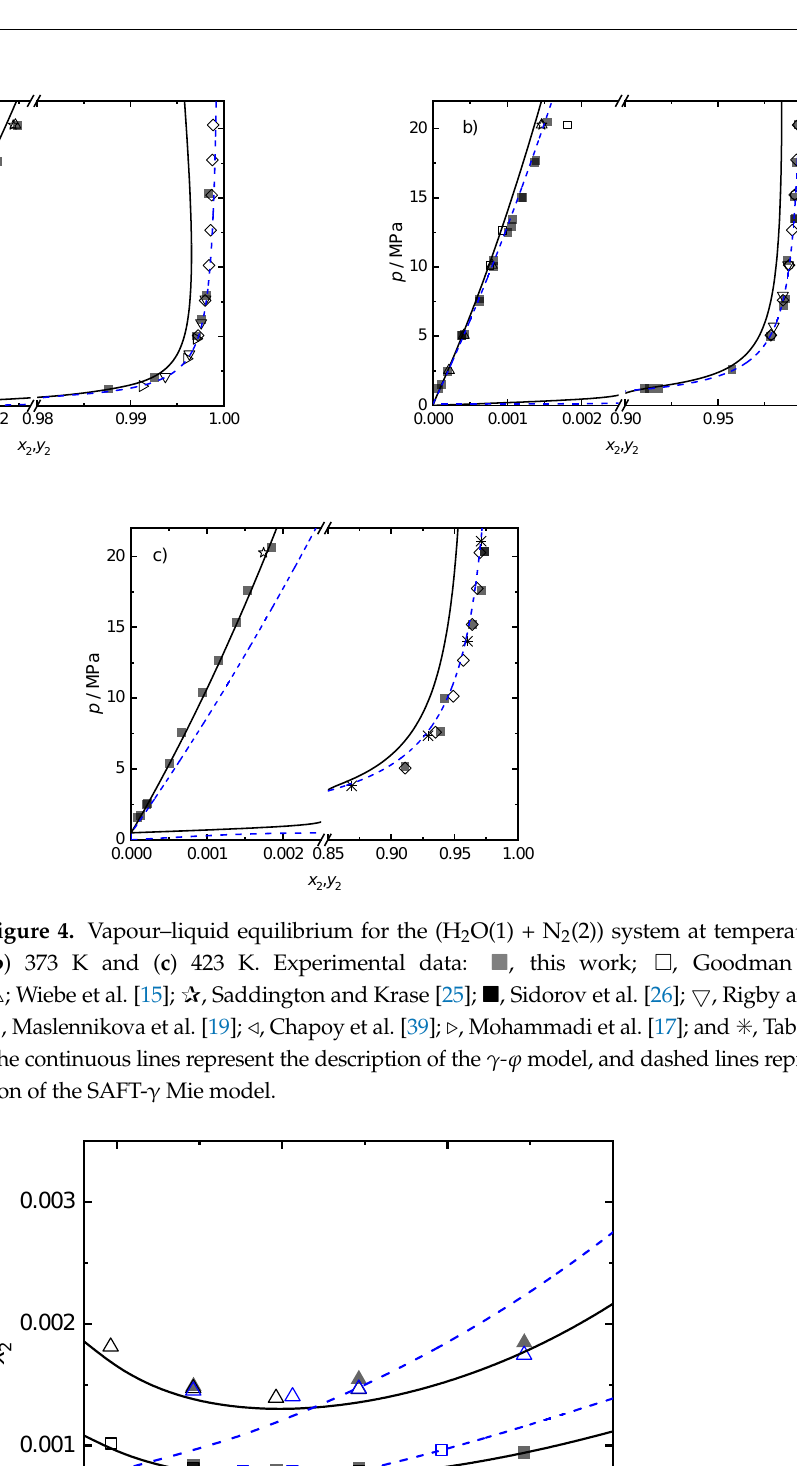
0.0000 0.0006 0.0012 0.98